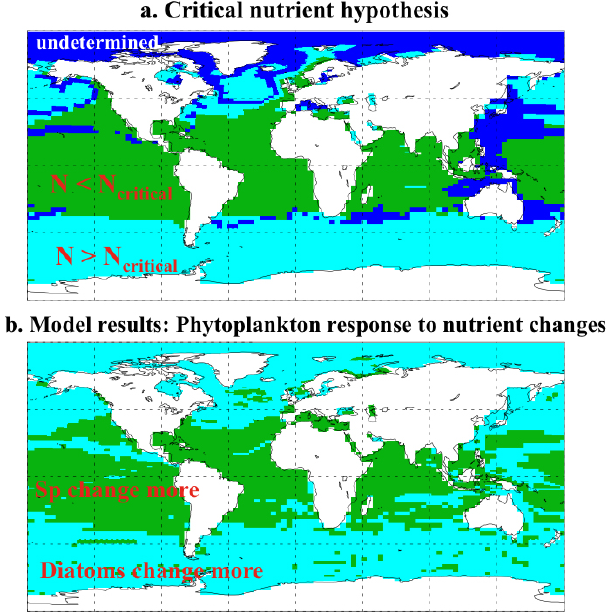
Fig. 10. (a) Critical nutrient hypothesis. Green areas: N ≤ N critical and hypothesis predicts that small phytoplankton specific growth rates should change more with nutrient change than diatom growth rates. Light blue areas: N > N critical and diatom growth rates should change more than small phytoplankton growth rates. Dark blue areas: no theoretical prediction possible as diatoms and small phytoplankton are limited by different nutrients (e.g., diatoms are Si limited while small phyto are N limited in W Pacific). Area separation based on point-by-point comparisons of surface limit- ing nutrient (NO 3 or Fe or PO 4 ) values with the corresponding critical nutrient value calculated from Eq. (17) in the text. (b) Climate model results . Green areas: model regions where small phytoplankton growth rates change more than diatom growth rates | . Light in response to nutrient perturbations | 1µ nutr sp | > | 1µ nutr diat | > | 1µ nutr | . blue areas: diatom growth rates change more | 1µ nutr sp diat 1µ nutr sp ,1µ nutr terms calculated as linear trends for the 1980–2100 diat period (as in Figs. 6, 7, 8). The critical nutrient hypothesis predicts well the model results; green and light blue areas in (a) coincide nicely with green and light blue areas in (b),